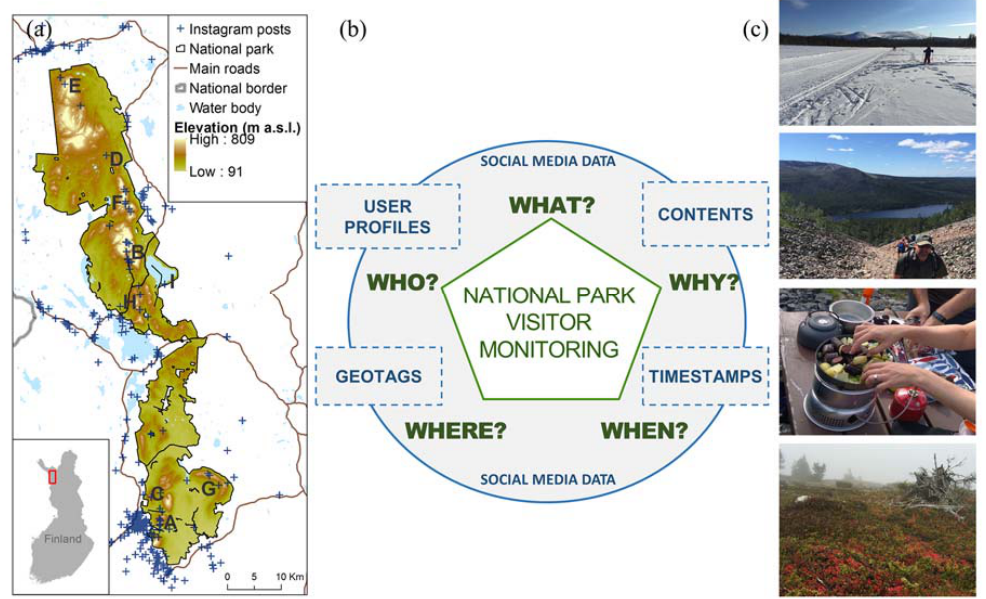
Figure 1. ( a ) Instagram post locations from the case study area of Pallas-Yllästunturi National Park (PY) in Finnish Lapland; ( b ) Framework for using social media data (geotags, timestamps, contents, user profiles) for studying the spatial patterns (where), temporal patterns (when) of visitors/social media users (who) and their activities (what), and motivations (why) (modified from [14]); and ( c ) examples of social media image content from the national park.